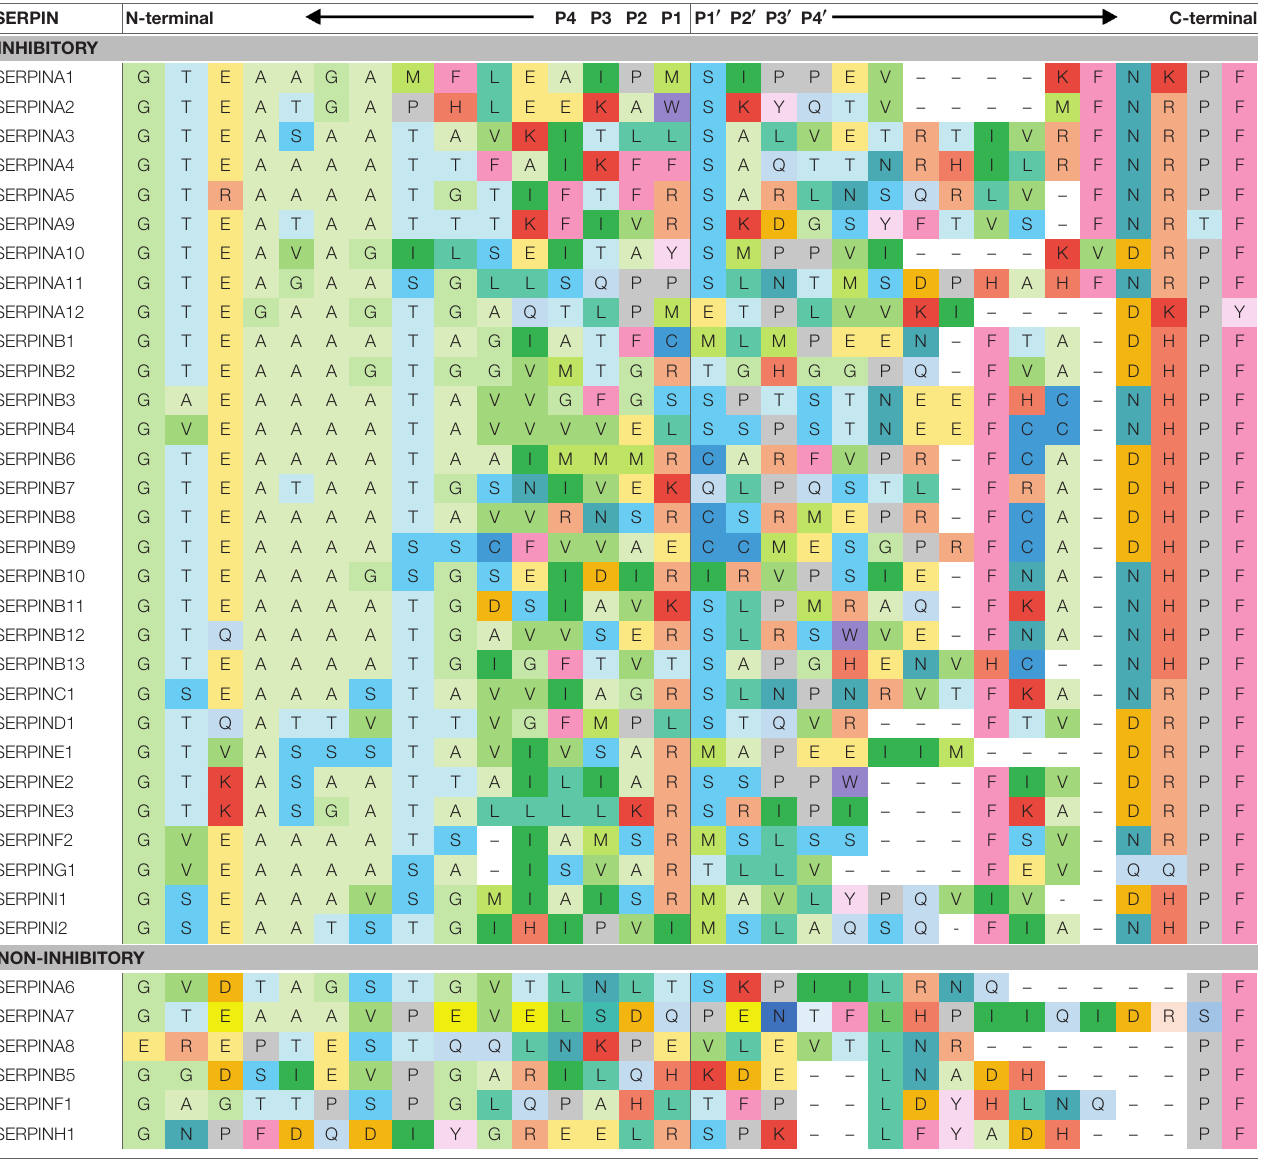
TABLE 1 | Amino acid sequence alignments of human SERPIN reactive center loop. SERPIN